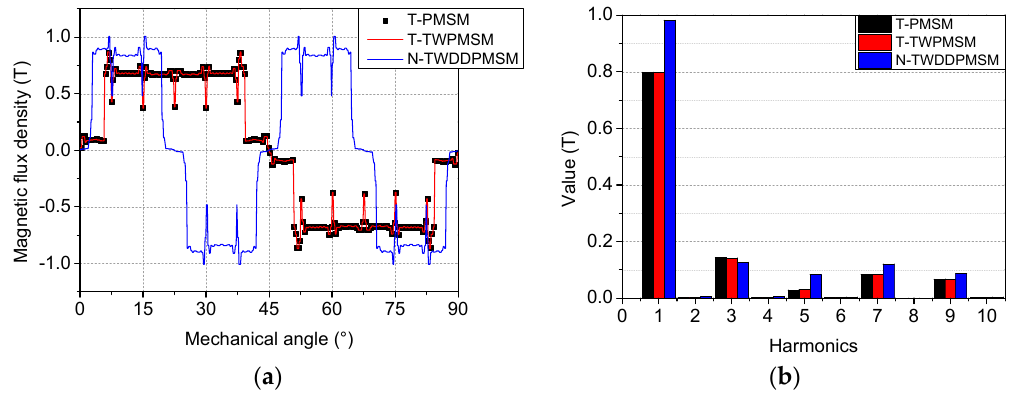
Figure 9. Air-gap flux density waveforms of three motors under no load: ( a ) air-gap flux density waveforms; ( b ) harmonics of air-gap flux density.